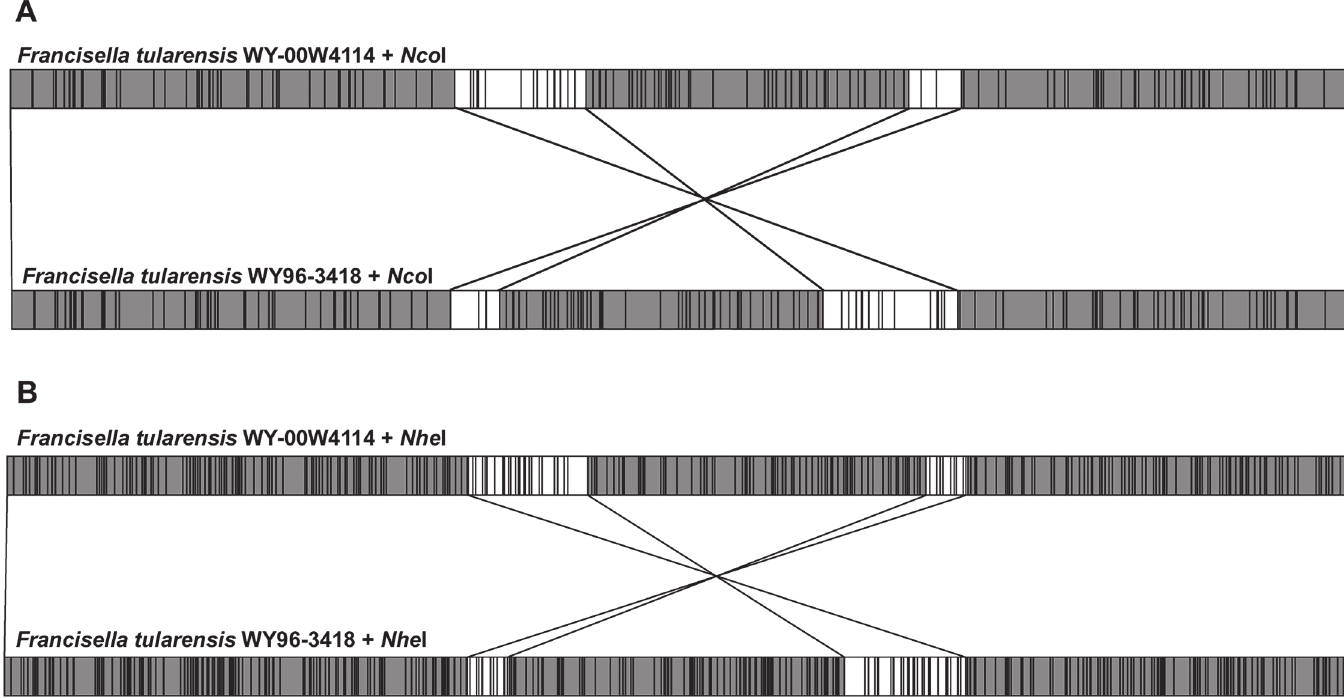
Fig 1. Whole genome mapping of F . tularensis subtype A.II strains WY-00W4114 and WY96-3418. Nco I (A) and Nhe I (B) whole genome maps of F . tularensis WY-00W4114 (top linearized chromosome) compared to the corresponding theoretical in silico digestion of F . tularensis WY96-3418 (GenBank accession number CP000608, bottom linearized chromosome). Vertical lines within the genome maps denote the restriction endonuclease sites for Nco I (A) or Nhe I (B). Lines connecting the chromosomal restriction maps of WY-00W4114 and WY96-3418 and the adjacent unshaded genomic areas denote translocated